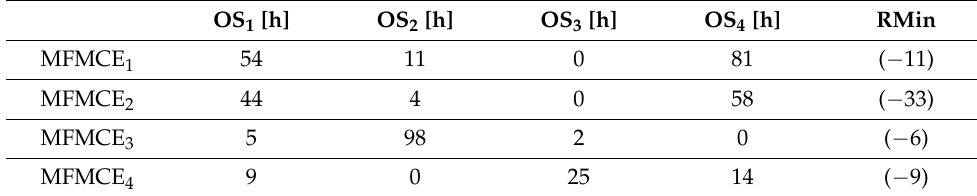
Table 3. Cross combination after reduction by the subtracted row minima.